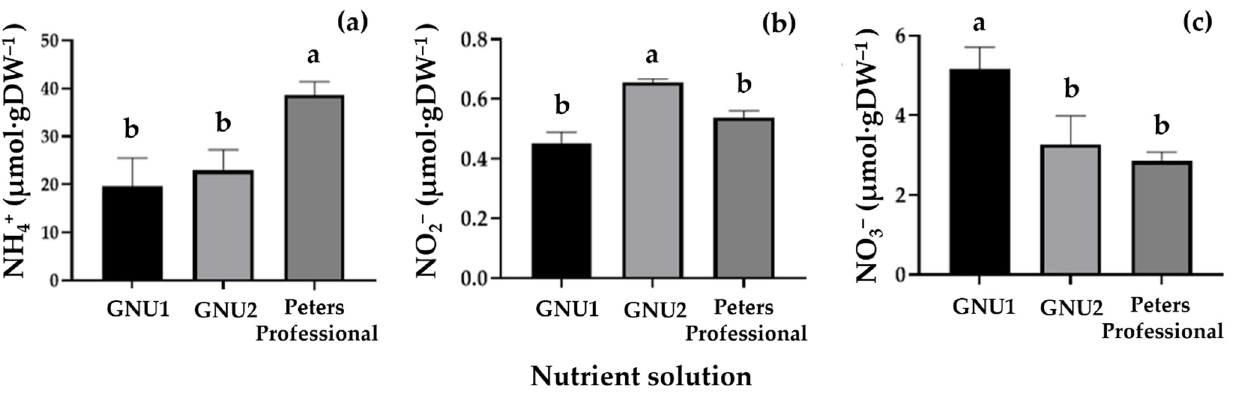
Figure 6. Tissue contents of NH 4+ ( a ), NO 2 − ( b ), and NO 3 − ( c ) in the leaves of Ssamchoo as affected by the nutrient solution 28 days after sowing in the experiment 1. Vertical bars represent the SEs of three biological replicates ( n = 3). Significant differences among treatments are indicated by lowercase letters at p ≤ 0.05 according to the Duncan’s multiple range test, and different lowercase letters indicate significant differences.